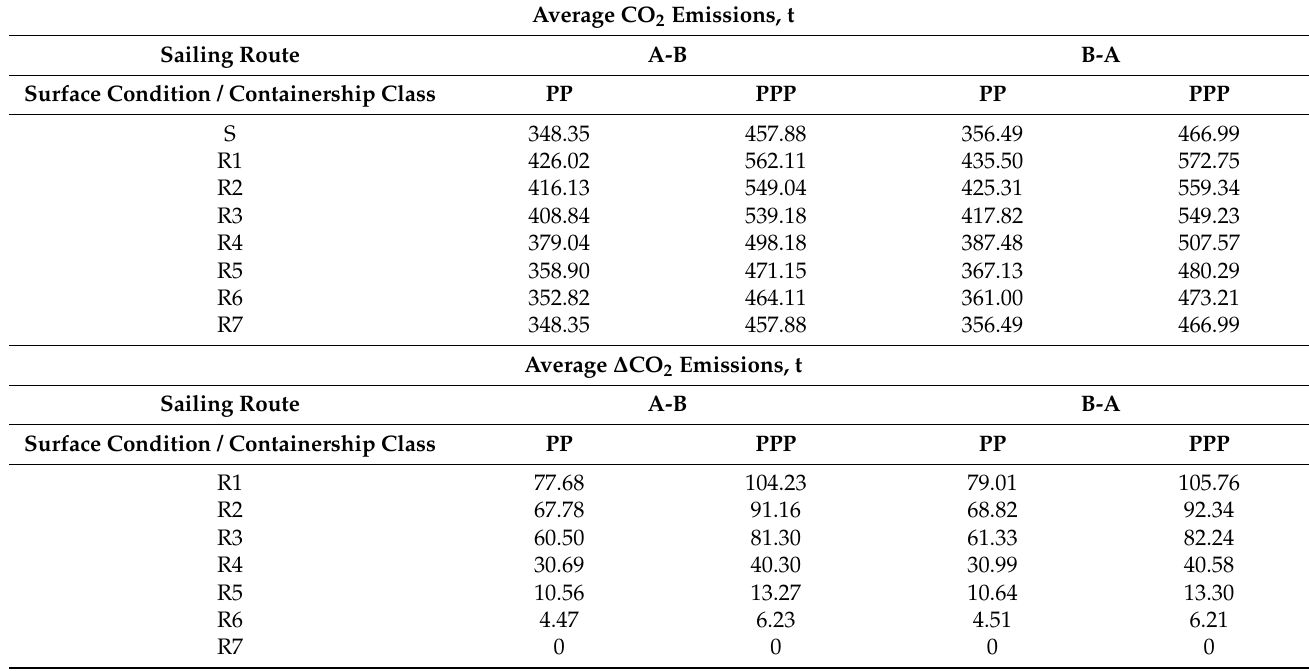
Table 5. The obtained average CO 2 emissions and increase in CO 2 emissions per route for PP and PPP containership